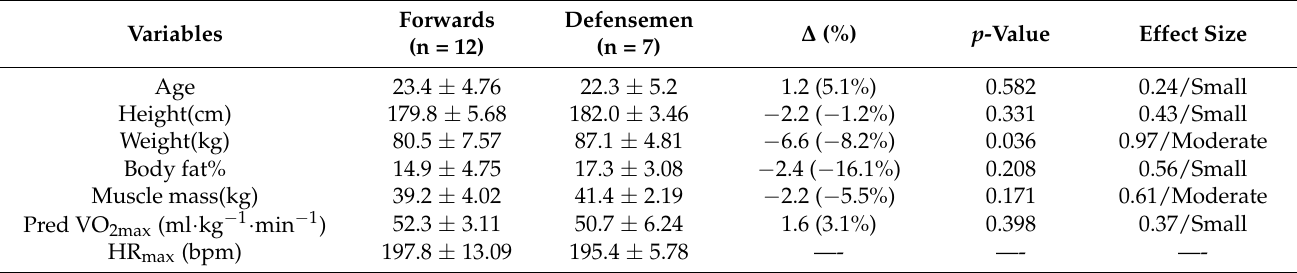
Table 1. Physical characteristics of the volunteers.